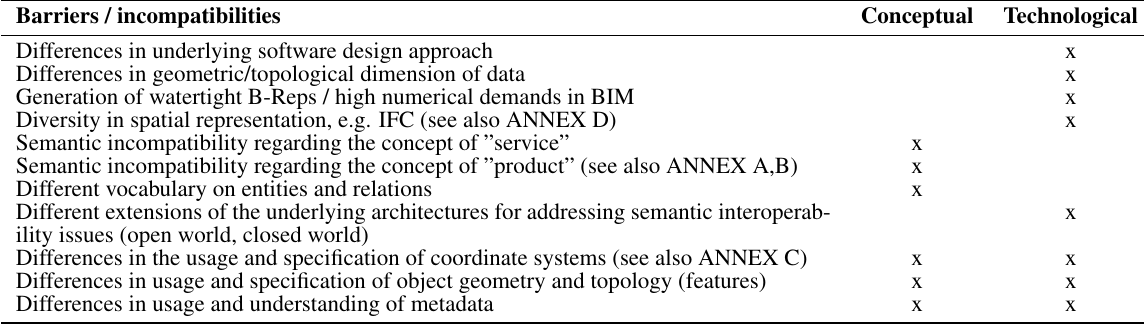
Table 2. Additional pragmatic BIM/GIS incompatibilities that are described in the ISO/TR. The table just names the incompatibilities, further information is found in the